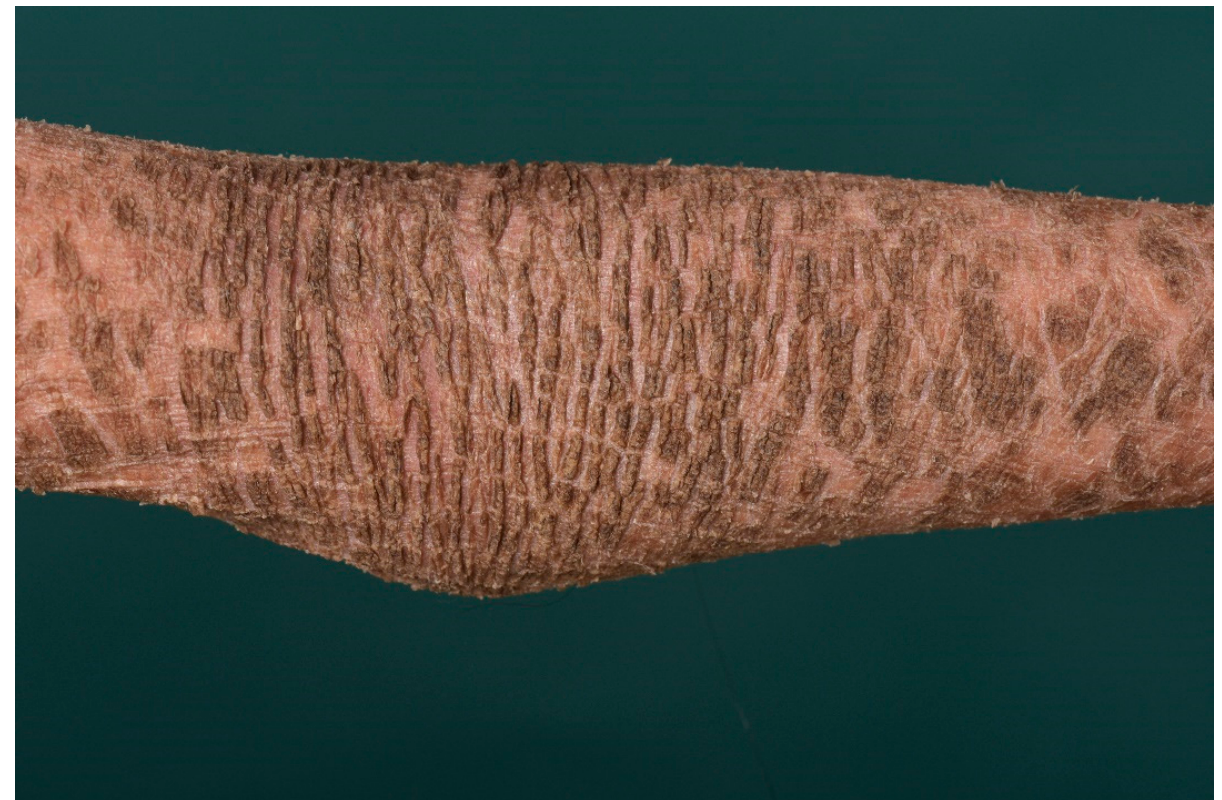
Figure 3. Lamellar ichthyosis. Dark brownish lamellar scaling in a patient with transglutaminase − 1 deficiency.